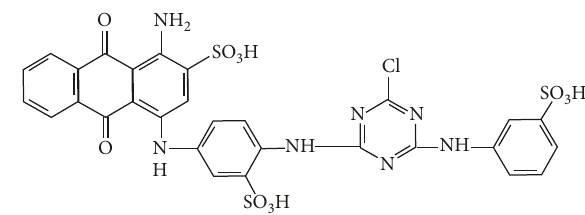
Figure 1: Chemical structure of Cibacron blue [28].